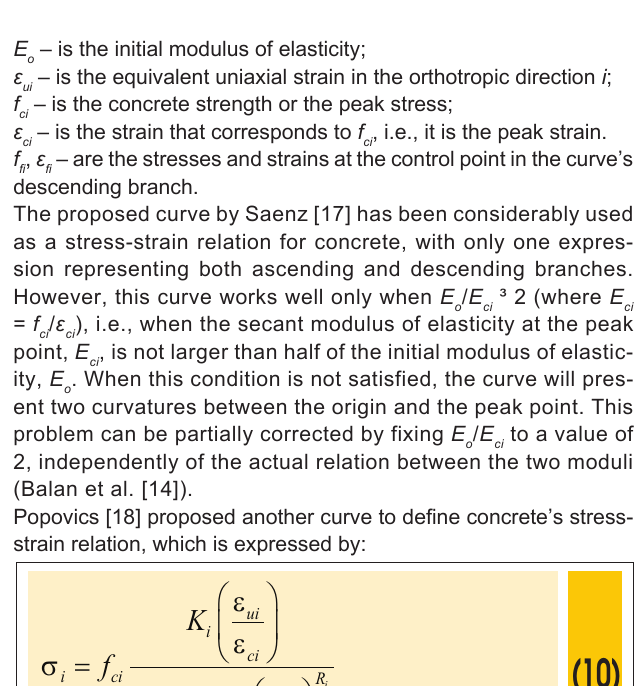
Figure 2 – Stress-strain curves for concrete subjected to monotonic loads: (a) response in compression; (b) response in